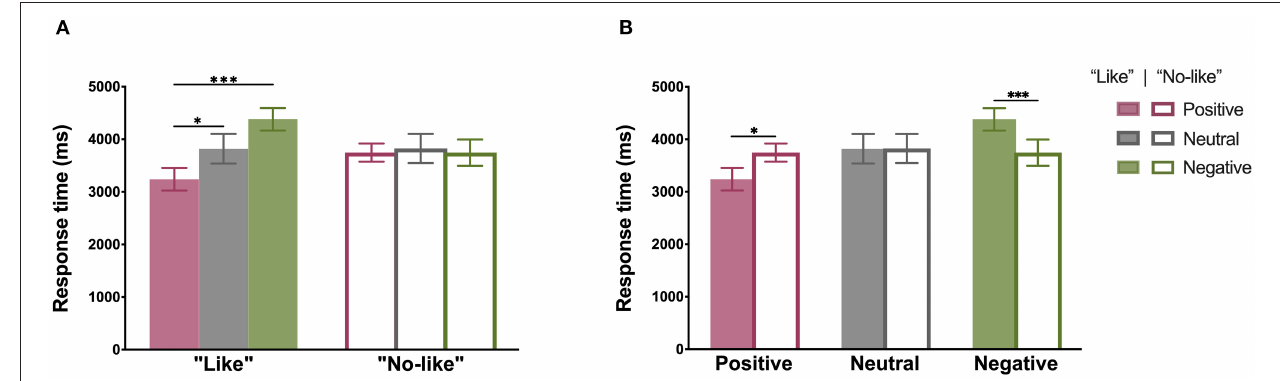
FIGURE 3 | “Like”/“No-like” response times. (A) Emotional valence of responses under “Like” vs. “No-like” conditions (positive vs. neutral: Cohen’s d = − 0.31, positive vs. negative: Cohen’s d = − 0.71). (B) “Like”/“No-like” effects for different emotional valence conditions (positive: “Like” vs. “No-like”: Cohen’s d = − 0.35; negative: “Like” vs. “No-like”: Cohen’s d = 0.36). Error bars indicate standard errors. * p < 0.05; *** p < 0.001.